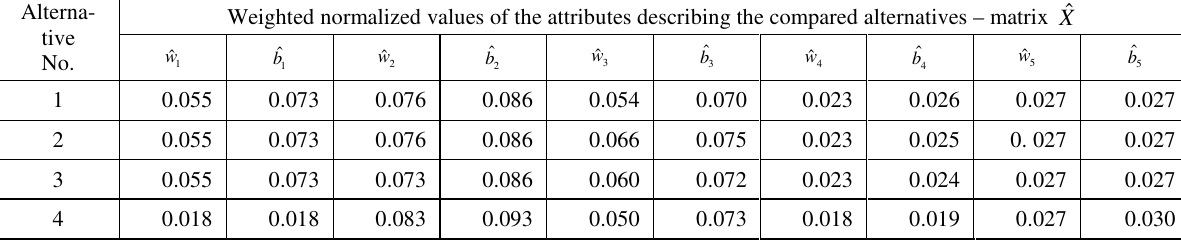
Table 3. Decision results according to a COPRAS-G method ( R j – ascending rank of alternatives. The smallest is the best)